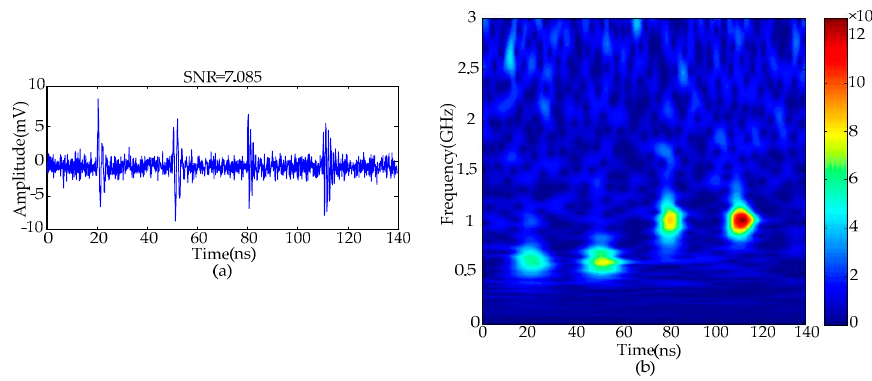
Figure 4. UHF PD signals with suppressed periodic narrowband noise: ( a ) in time domain; ( b ) in time-frequency domain.